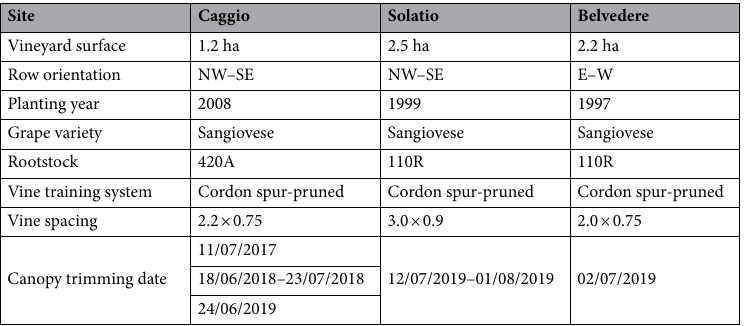
Table 1. Experimental vineyards. Vine spacing: distance between rows and between vine along the row. Canopy trimming: management practice which consists of removing the apical part of the shoot containing younger